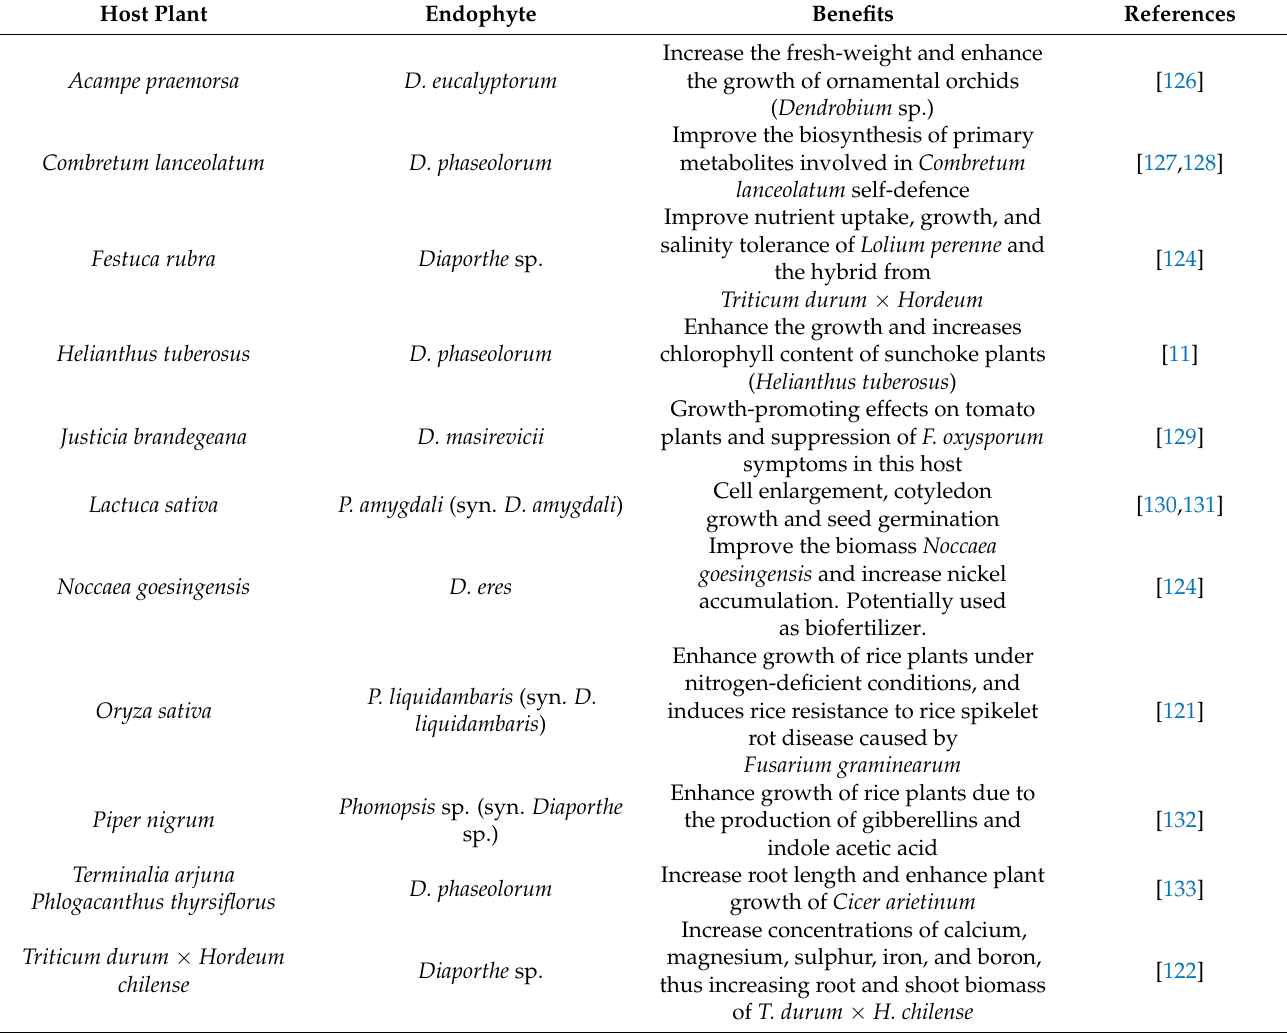
Table 3. Benefits of endophytic Diaporthe to